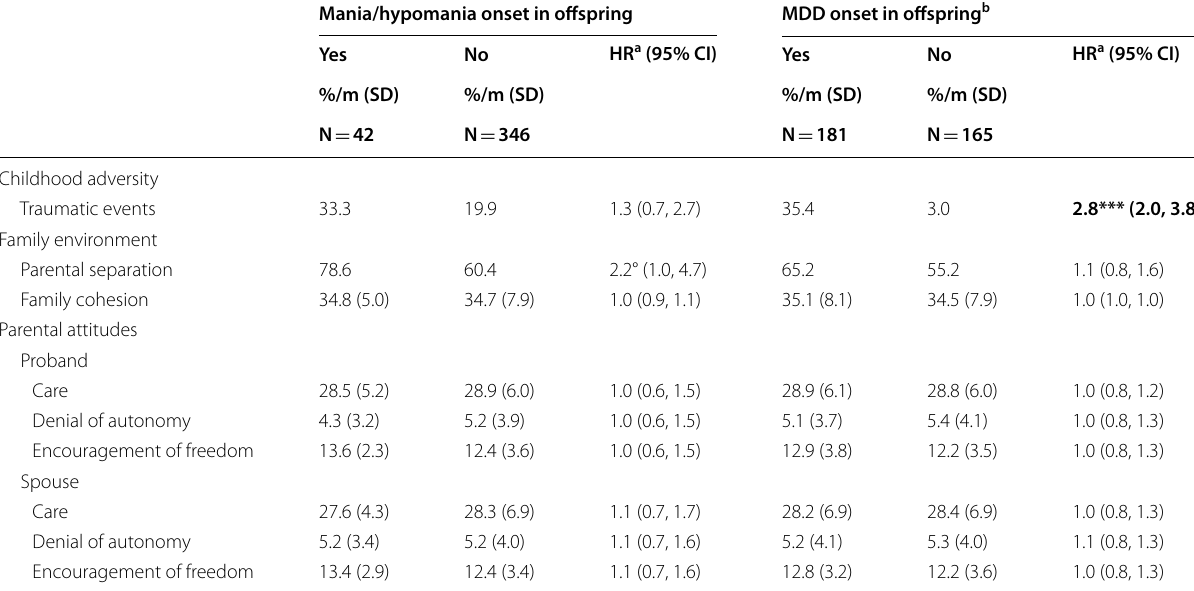
Statistically significant values are in bold